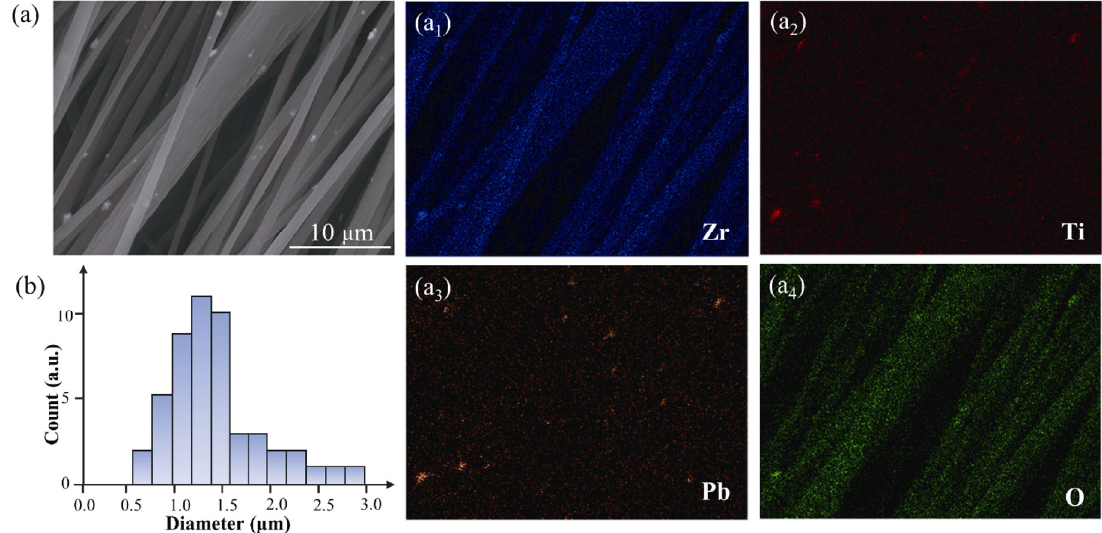
Fig. 2 (a) SEM image of 10 wt% PZT/PVDF electrospinning fibers: (a 1 –a 4 ) the element mapping of electrospinning fibers. (b) Statistical results of the fiber diameter